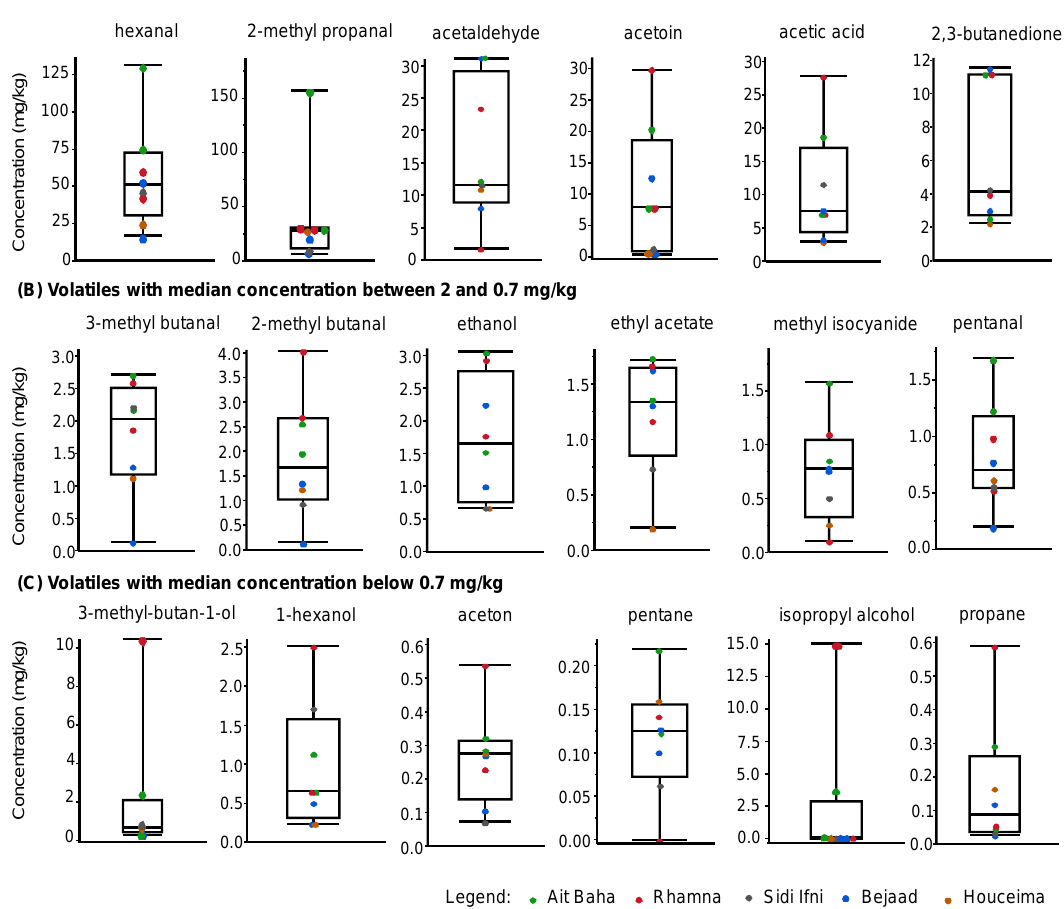
Figure 2. Box plot diagrams of volatile compounds extracted from cactus seed oil from different locations in Morocco by dynamic headspace GC and detection by FID. The volatiles are sorted by their median concentration, starting with the largest concentration. ( A ) shows the volatiles with the highest median concentration ranging from 51 to 4 mg/kg; ( B ) volatiles with a median concentration between 2 and 0.7 mg/kg and ( C ) volatiles with median concentration below 0.7 mg/kg).